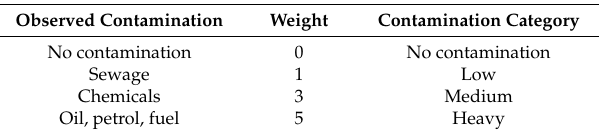
Table 2. Ranking of